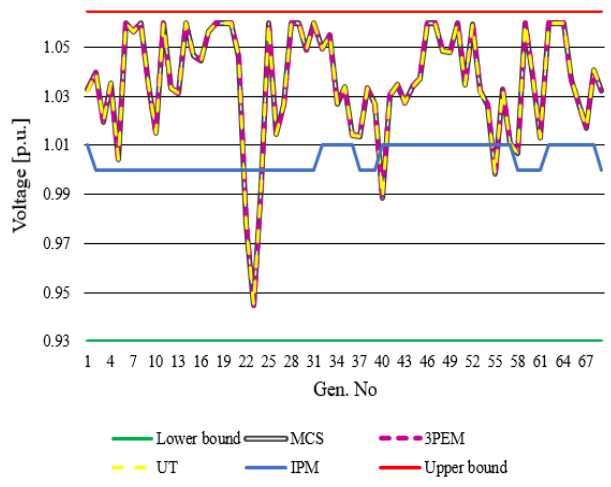
Fig. 4. Profiles of generator voltage (per unit)